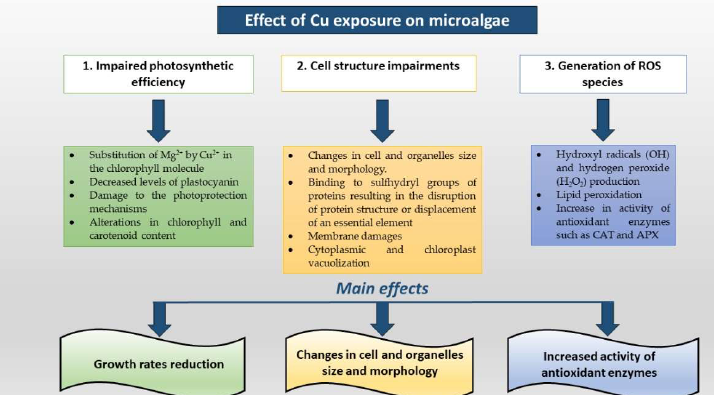
Figure 2. Detrimental effects of Cu on microalgal photosynthetic apparatus, on cell and organelle impairments and on the activity of antioxidant enzymes.